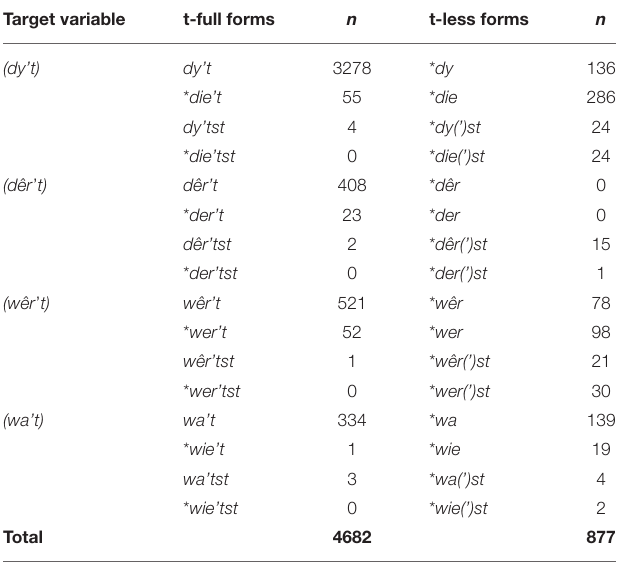
TABLE 5 | Characteristics of the Twitterers: gender, birth year (per decade) and spelling style (standard or phonetic Frisian) per number of tokens ( n = 5,559) and Twitterers ( N =